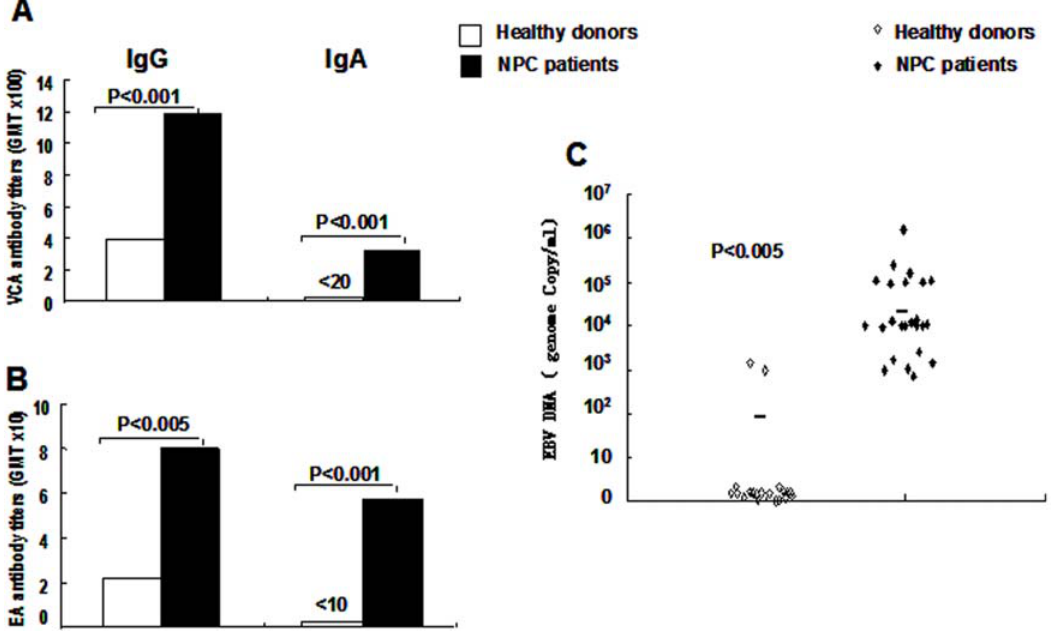
Figure 1. EBV VCA and EA antibody titers and EBV DNA in the serum of NPC patients and healthy EBV carriers. Antibody titers to EBV VCA IgG and IgA (A) and EA IgG and IgA (B) in the serum of healthy donors (n=20) and NPC patients (n=40); EBV DNA load (C) in healthy donors (n=20) and NPC patients (n=24); ns= non significant.